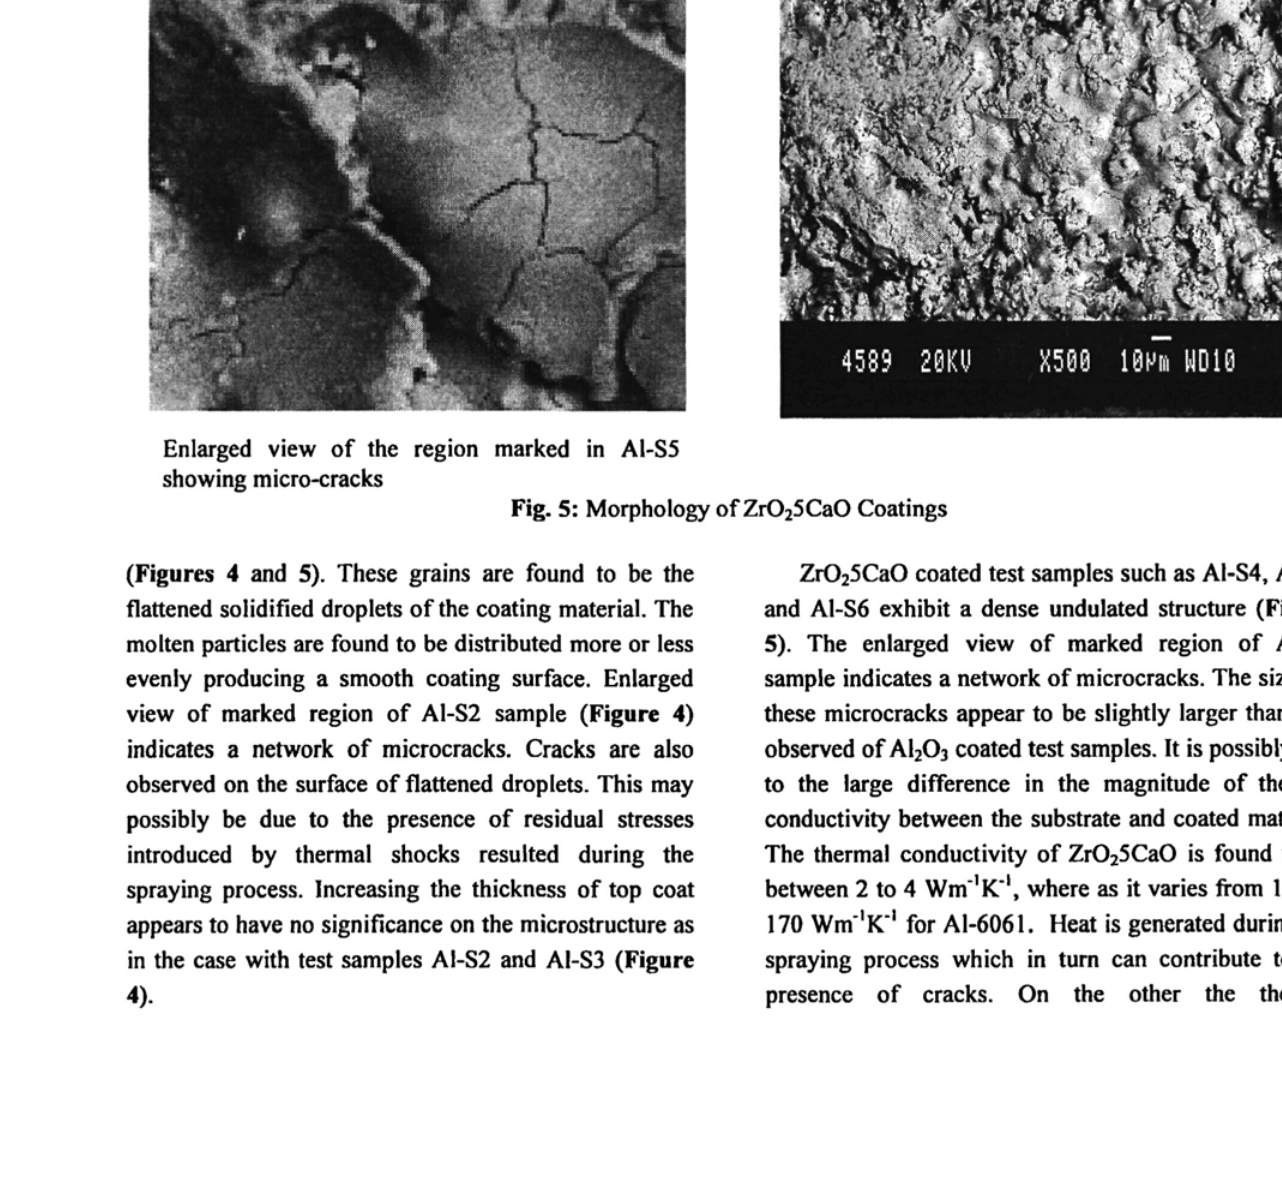
Fig. 5: Morphology of ZrO